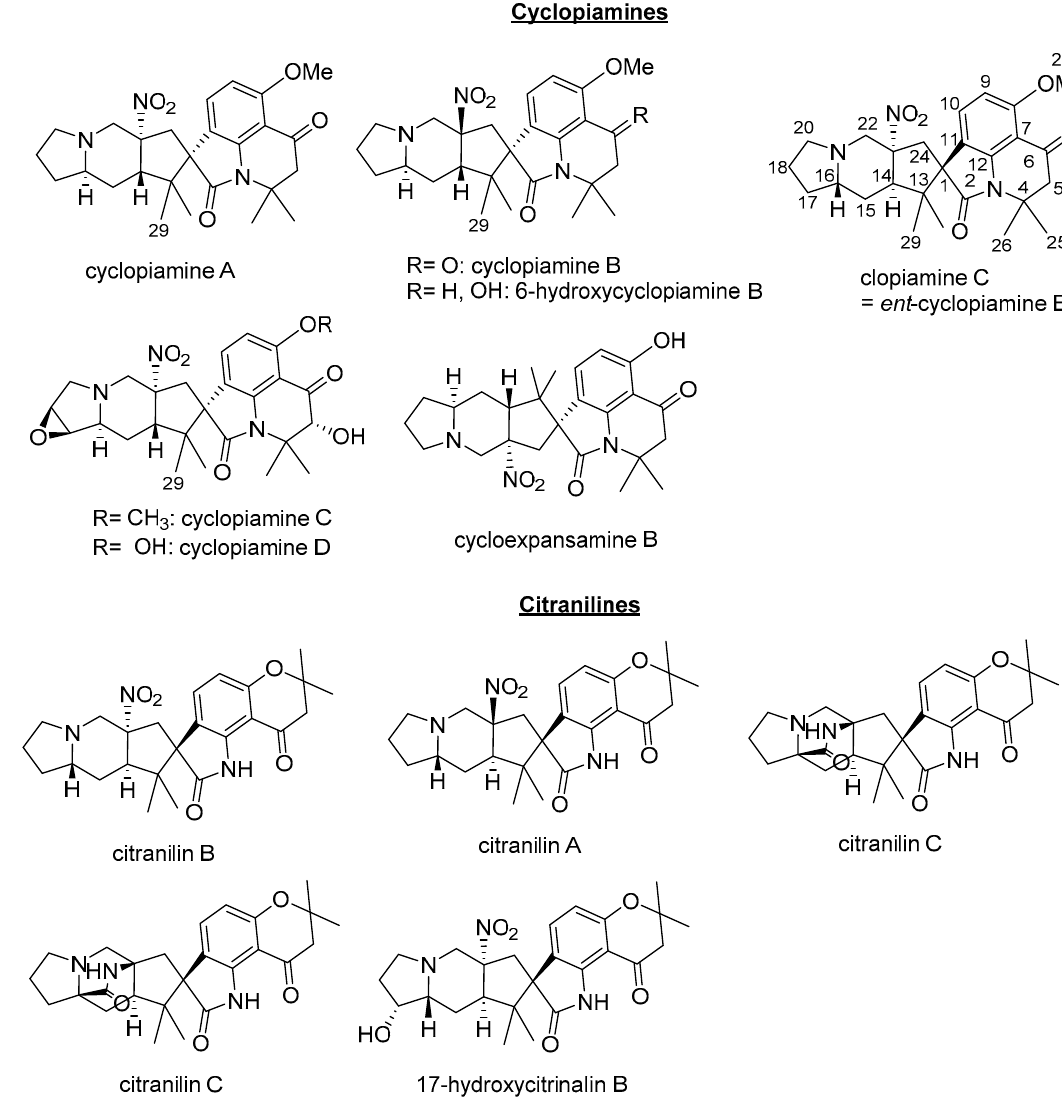
Figure 2. Structure of compound 1.